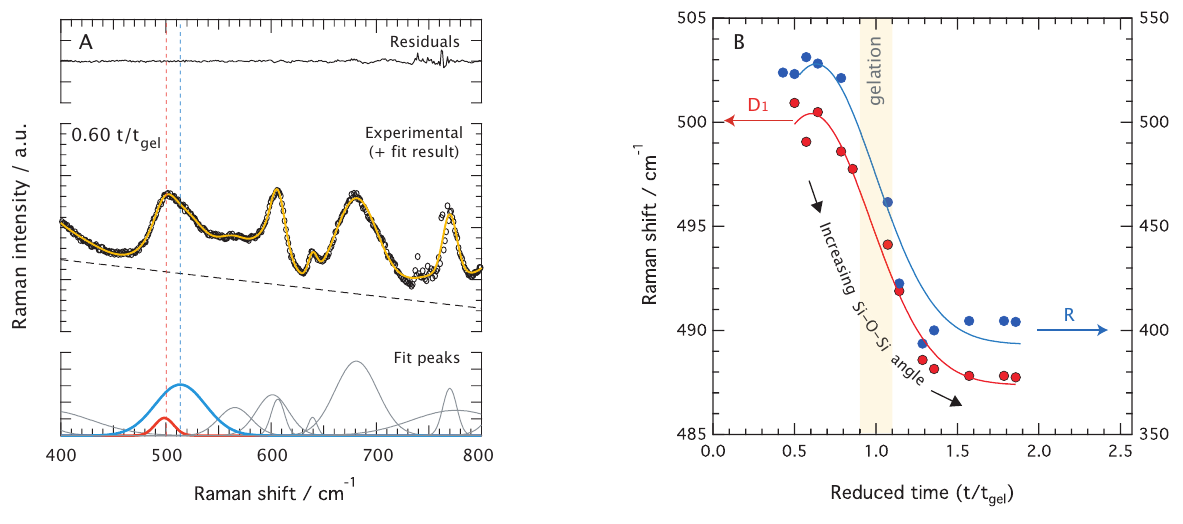
Left: Example of a peak-fit analysis for the spectrum of no ionic liquid added solution recorded at t/t = 0.60. The residuals (top), the fitting results (center), gel and the individual fitting components (bottom) are shown in separate panels. Frequency evolution as a function of reduced time of the fitting components associated to the n -membered ring vibrations for the representative case of the ionic liquid added solution (same color coding as in